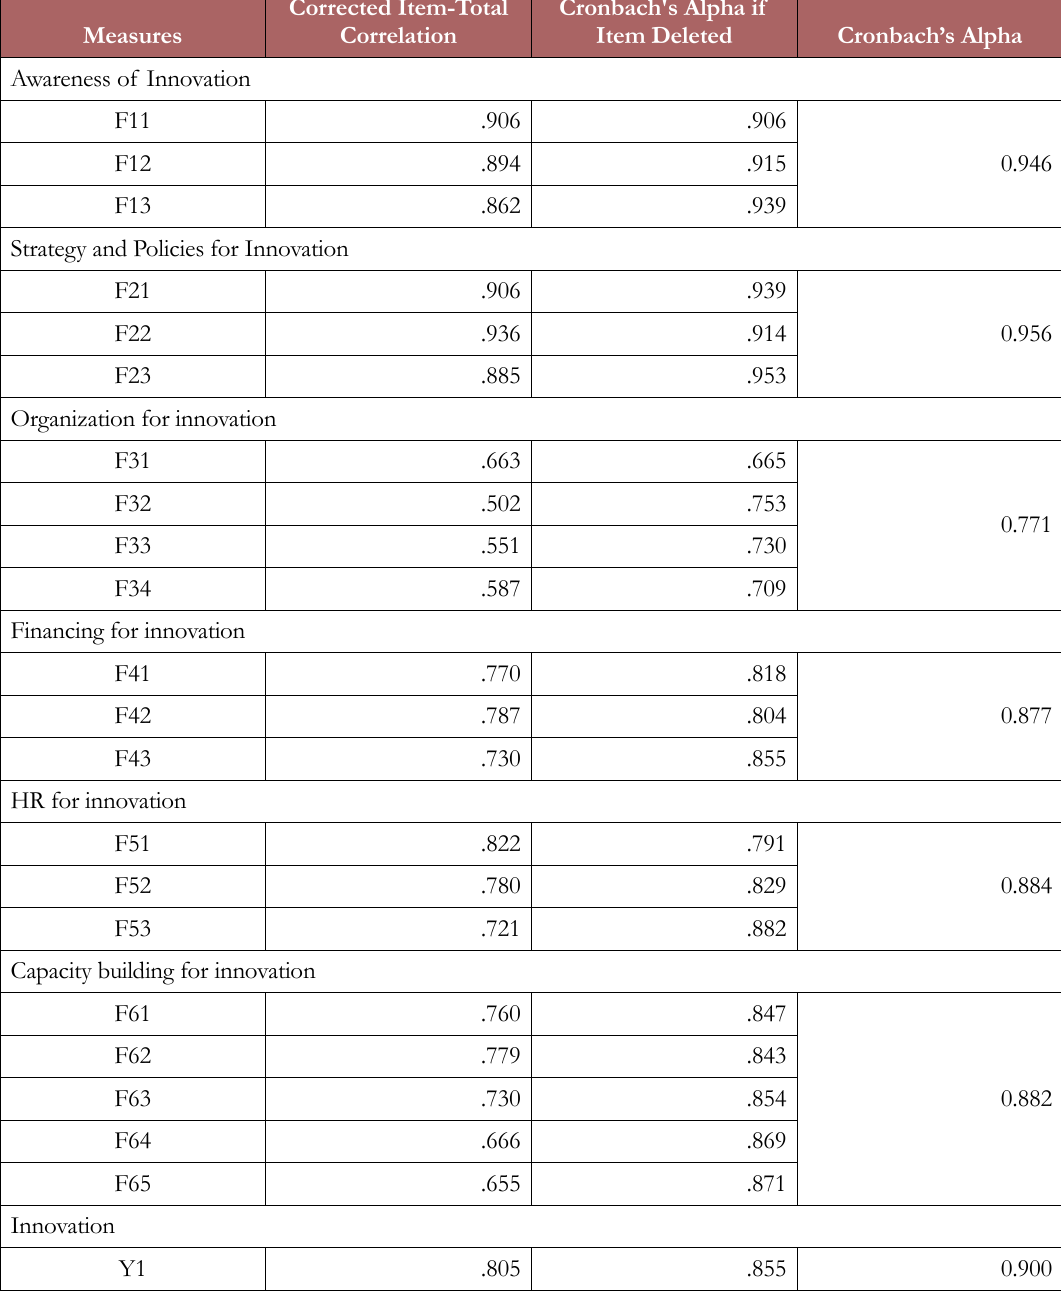
Table 2. Reliability